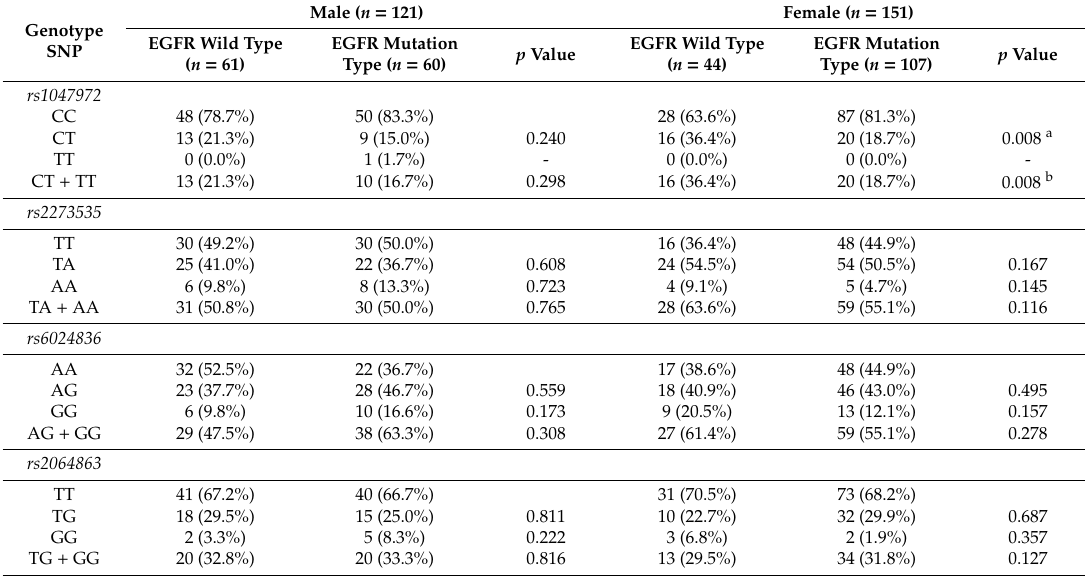
Table 3. Distribution frequency of AURKA genotypes of lung adenocarcinoma with di ff erent gender and epidermal growth factor receptor phenotypes.